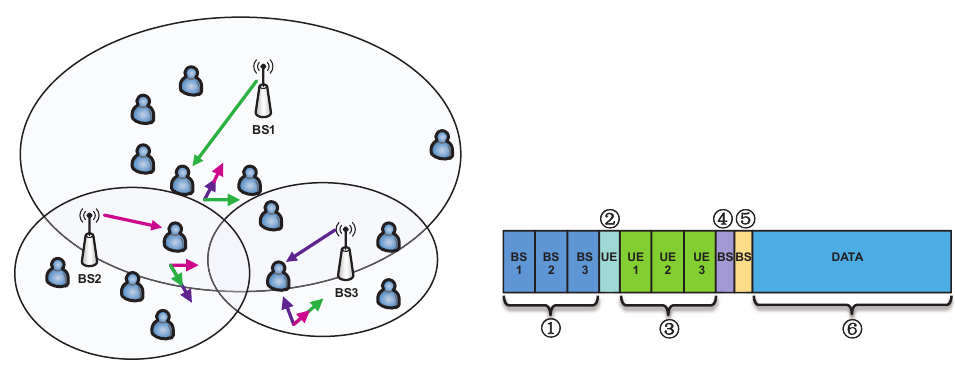
Figure 1. A cellular multi-cell downlink scenario and transmission procedures of